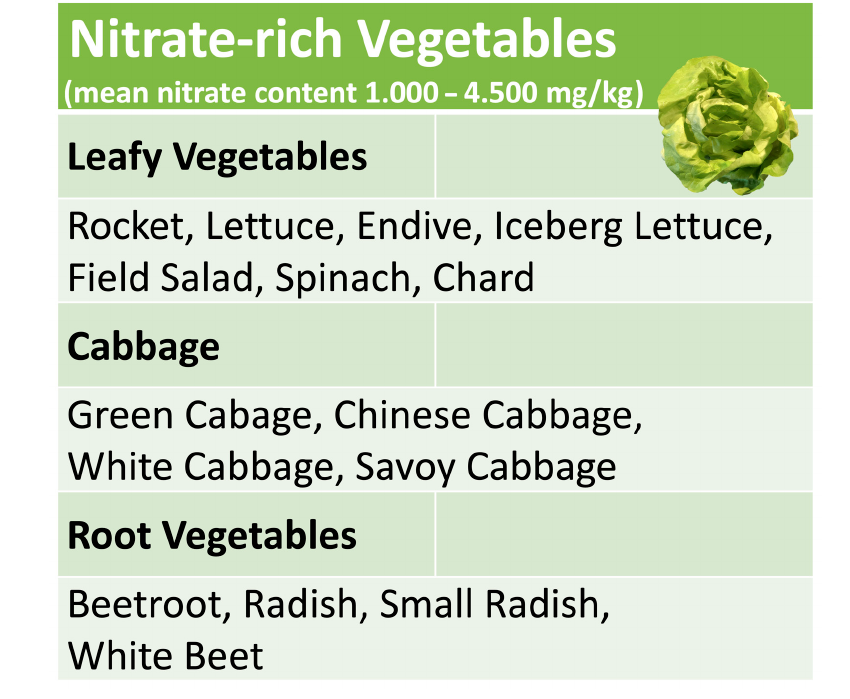
Figure 2. Common nitrate-rich vegetables.